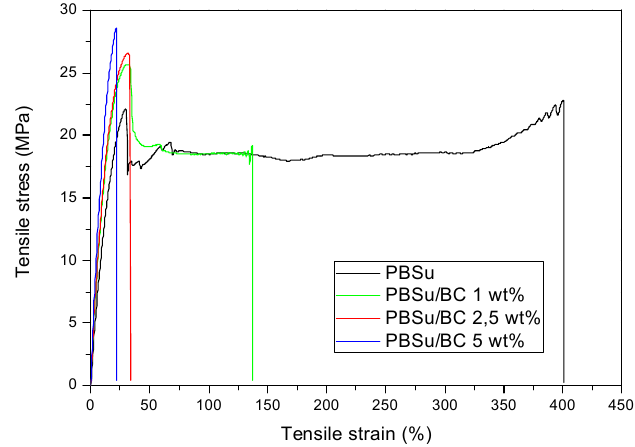
Figure 12. Stress–strain curves for neat PBSu and PBSu/BC biocomposites. Table 4. Mechanical properties of PBSu/BC